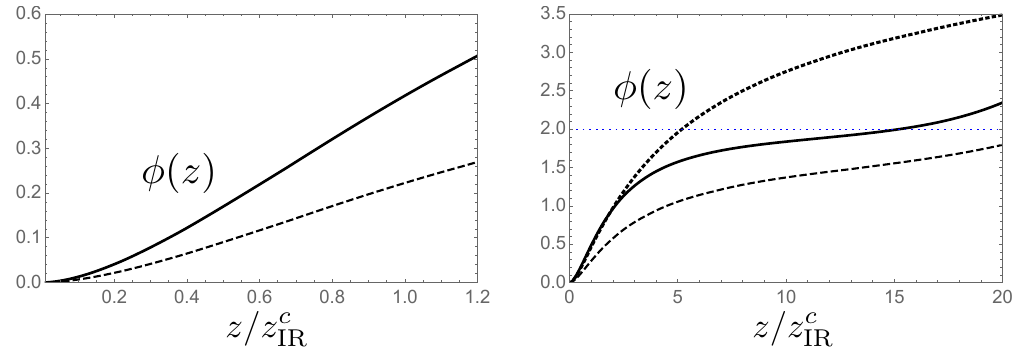
Figure 2 . 5D tachyon solutions (in units of 1 =L ) for ^ m 2 RIGHT: limit II with z IR = 20 z c line, and (cid:21) = (cid:0) 1, ^ (cid:20) 2 = 4 for the dotted line.